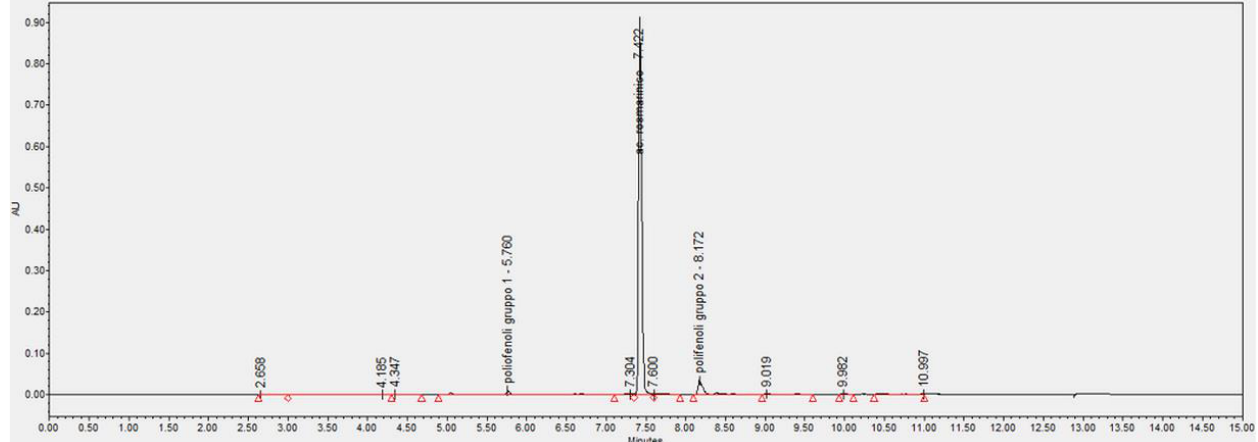
Figure 1. Chromatographic profile of the SOP at 330 nm of wavelength. The main peak with a retention time of 7.5 min corresponds to rosmarinic acid.